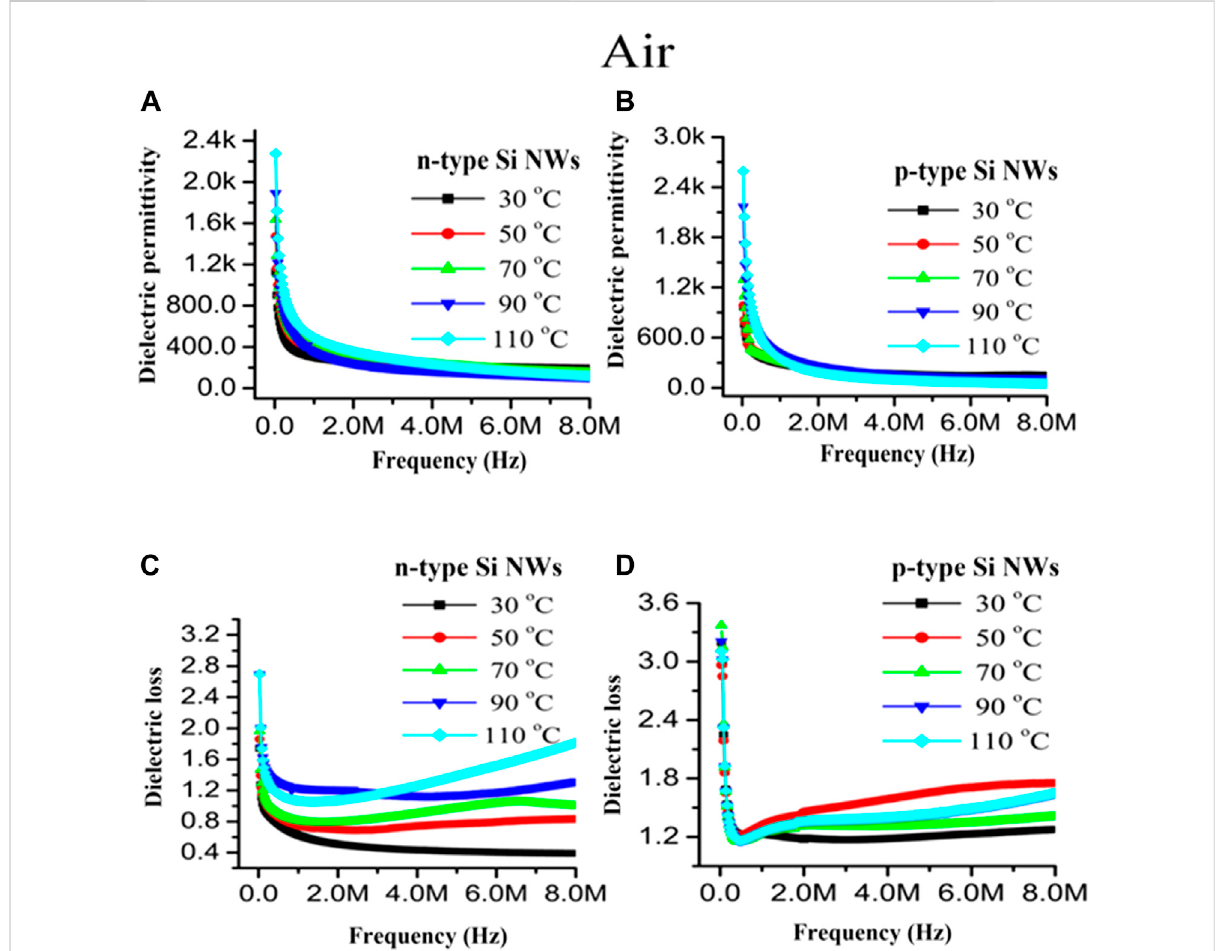
FIGURE 9 Dielectric permittivity and dielectric loss with varying temperature of (A,C) n 40 Si NWs and (B,D) p 40 Si NWs as a function of frequency,